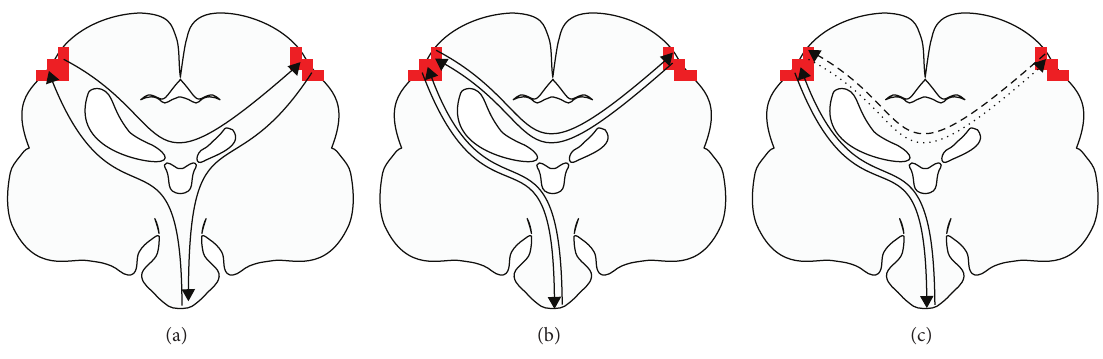
Figure 3: Task-based fMRI activation changes, in the presence of bilateral activation, require additional information for useful interpretation. Activation changes are often interpreted with the assumption that sensorimotor processing occurs primarily contralaterally, with interhemispheric relaying of information for supplementary processing (b). In cerebral palsy, however, sensory processing is often contralaterally organised, while motor signals emanate from the ipsilateral hemisphere (a). In addition, in cerebral palsy, stroke, and acquired brain injuries, imbalances in interhemispheric inhibition ((c); dashed lines) may be the primary factor influencing t-fMRI activation. Such organisations, and thus meaning of t-fMRI activation changes, can be elucidated via supplementary methods such as TMS and MEG